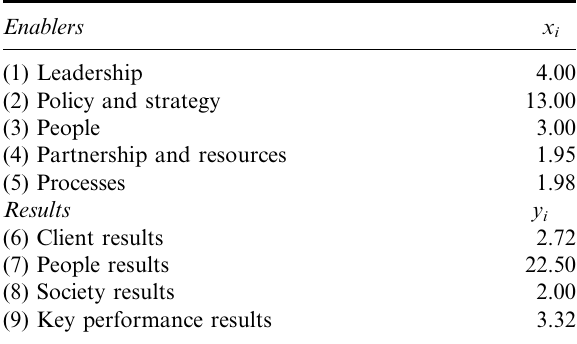
Table 3. Ratio of best practice and the performance of the observed company